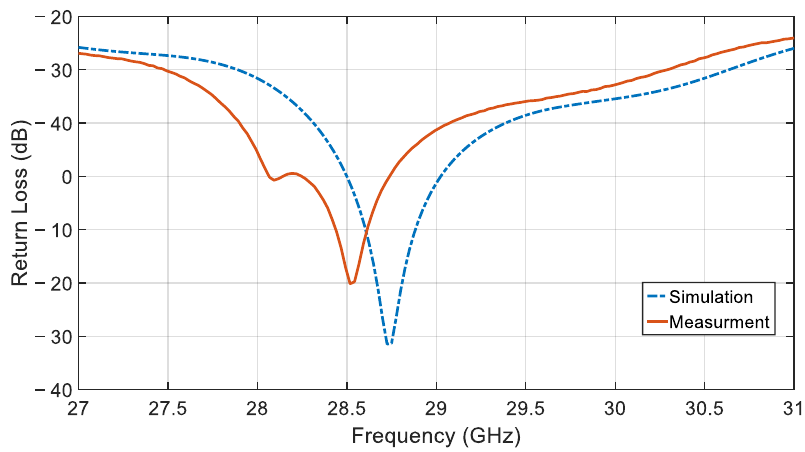
Figure 14. Return loss versus frequency of the proposed antenna array.